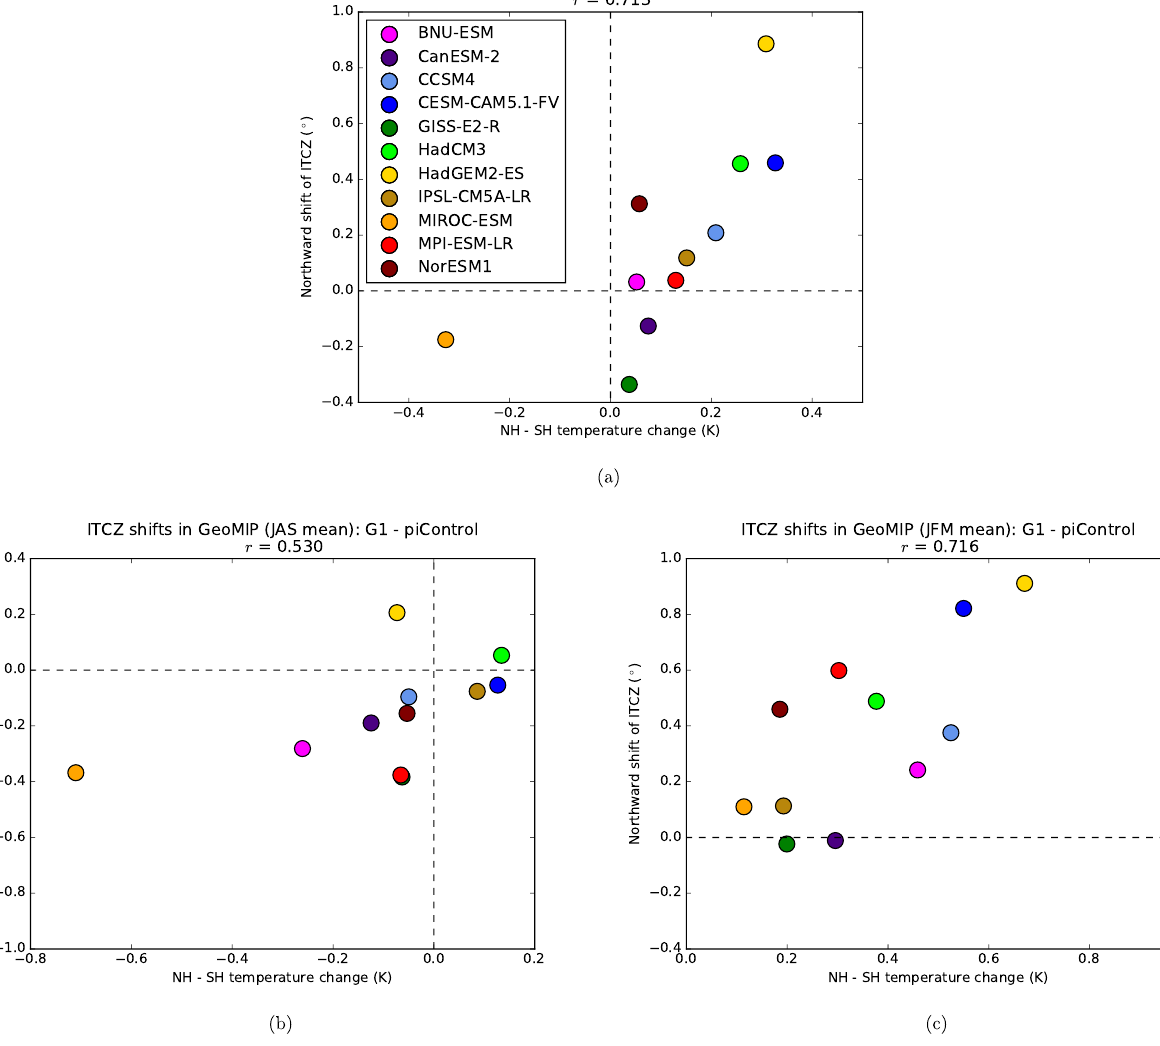
Figure 9. The ITCZ shift vs. the anomaly of the interhemispheric temperature contrast between G1 (years 11–50) and piControl (years 1–40), where r is the correlation coefficient. (a) The annual mean, (b) the JAS mean, and (c) the JFM